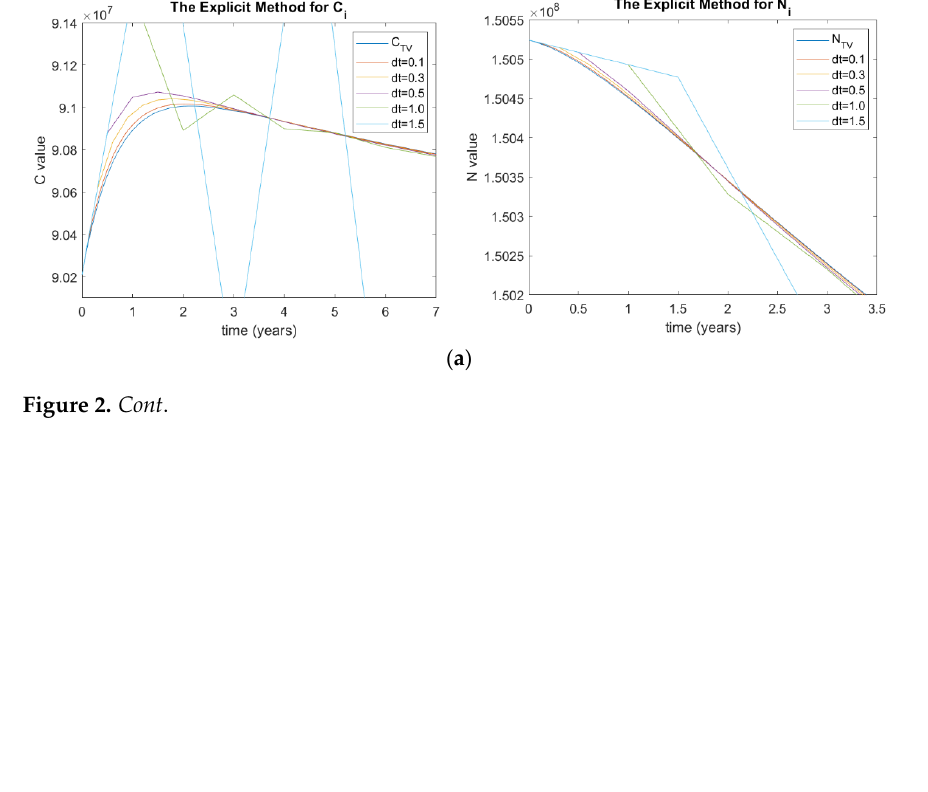
Table 5. The effect of changing ∆𝑡 on the results of N i .